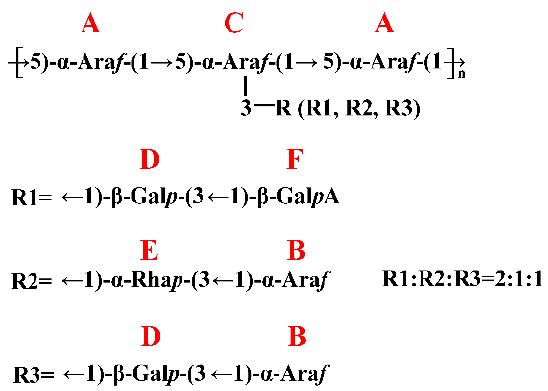
Figure 6. The repeating unit of JC-PS1.